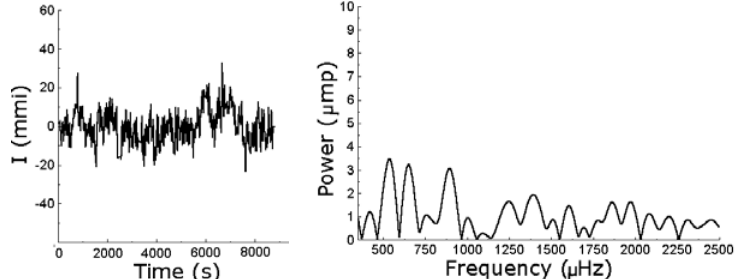
Fig. 8. NGC 246 Turkmenistan data: the left panel shows a light curve obtained from the November 16 run at Mt. Dushak-Erekdag in Turk- menistan. The right panel shows the